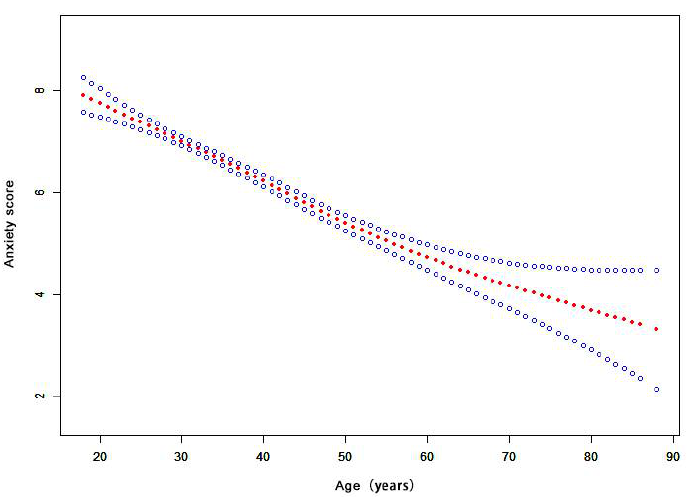
Figure 3. The dose-response relationship of age and anxiety score. (Notes: Generalized additive models; Outcome variable: anxiety score; Exposure variable: age; Adjustment variable: sex, marriage, education, occupation, family members, contact history).